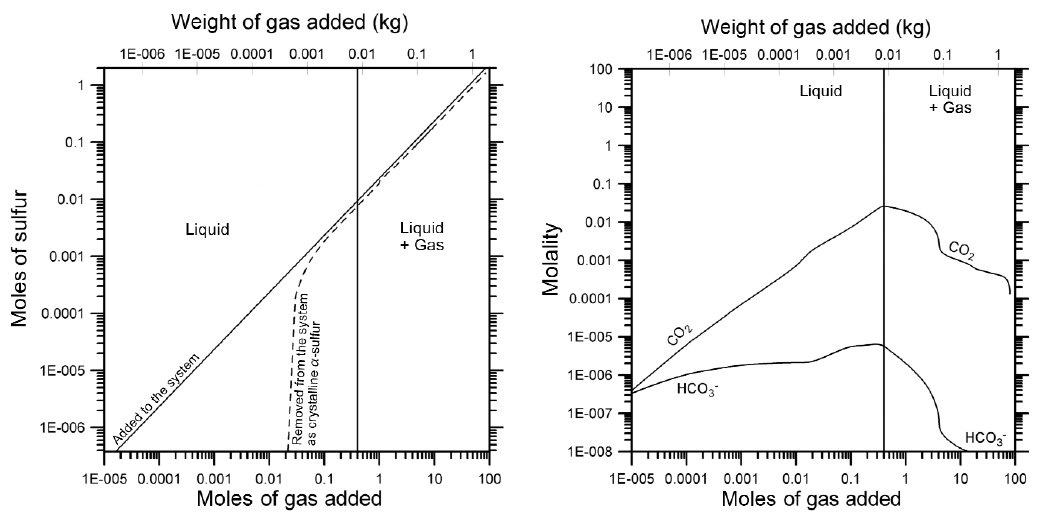
Fig. 7. Changes in dissolved carbonate species dur- ing the progressive addition of hot (915°C) magmat- ic gas into 1000 g of pure water initially at 25°C. Pressure was kept at 0.1 MPa throughout the simula- tion.